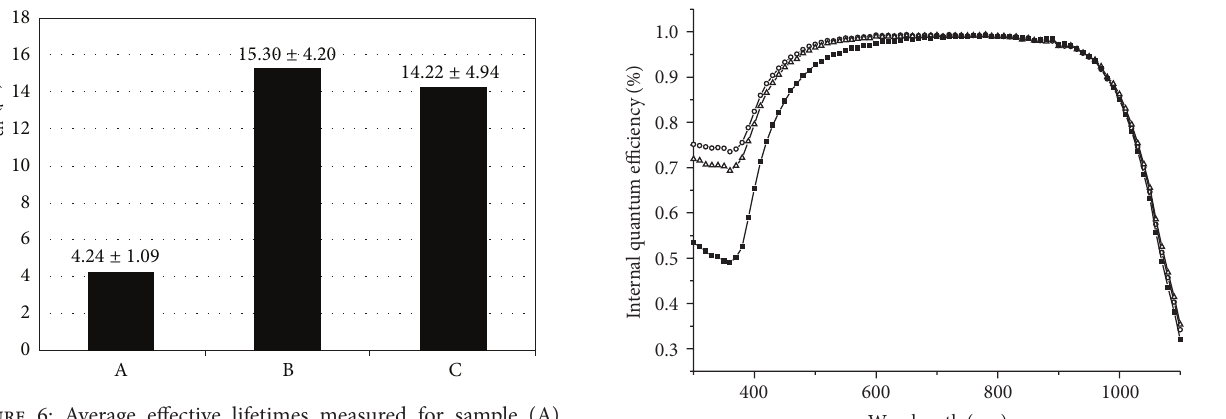
Figure 6: Average effective lifetimes measured for sample (A) without silicon films deposited, sample (B) with ∼ 4nm poly-silicon films, and sample (C) with ∼ 5nm a-Si films.